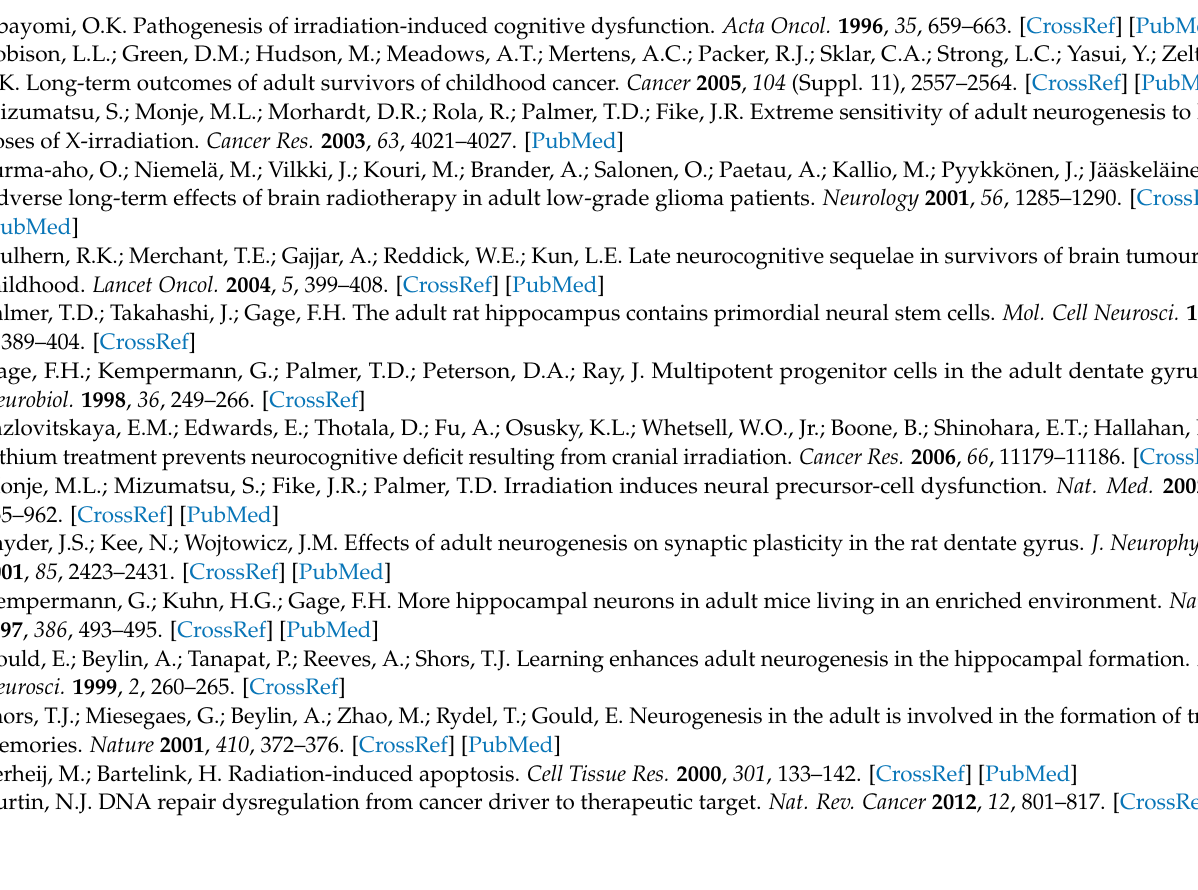
interactions, Figure S2: STRING analysis of selected protein interactions, Table S1: Primer